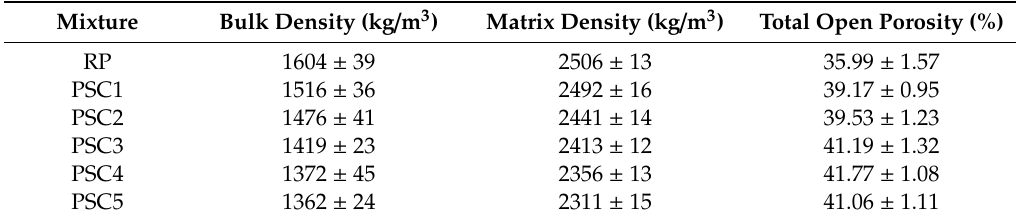
Table 2. Basic material Table 1. Plasters composition.